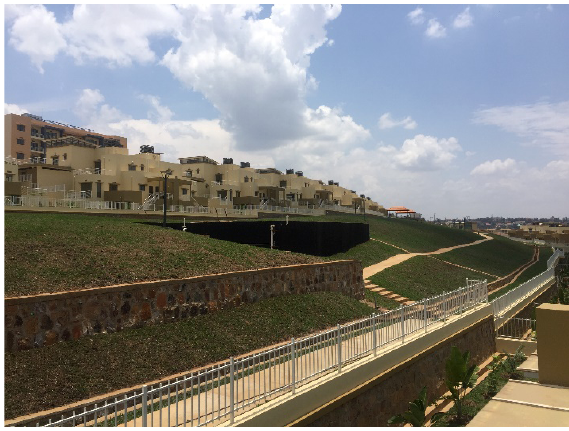
Figure 48. The narrow central green area, east view. Photograph by Manlio